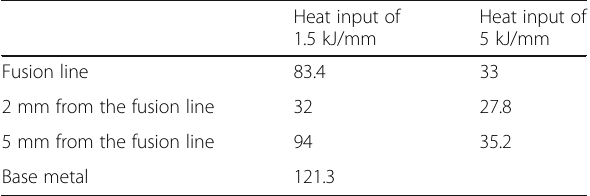
Table 6 Hardness (mean value) in various regions of HAZ of welded joint of steel 09G2FB